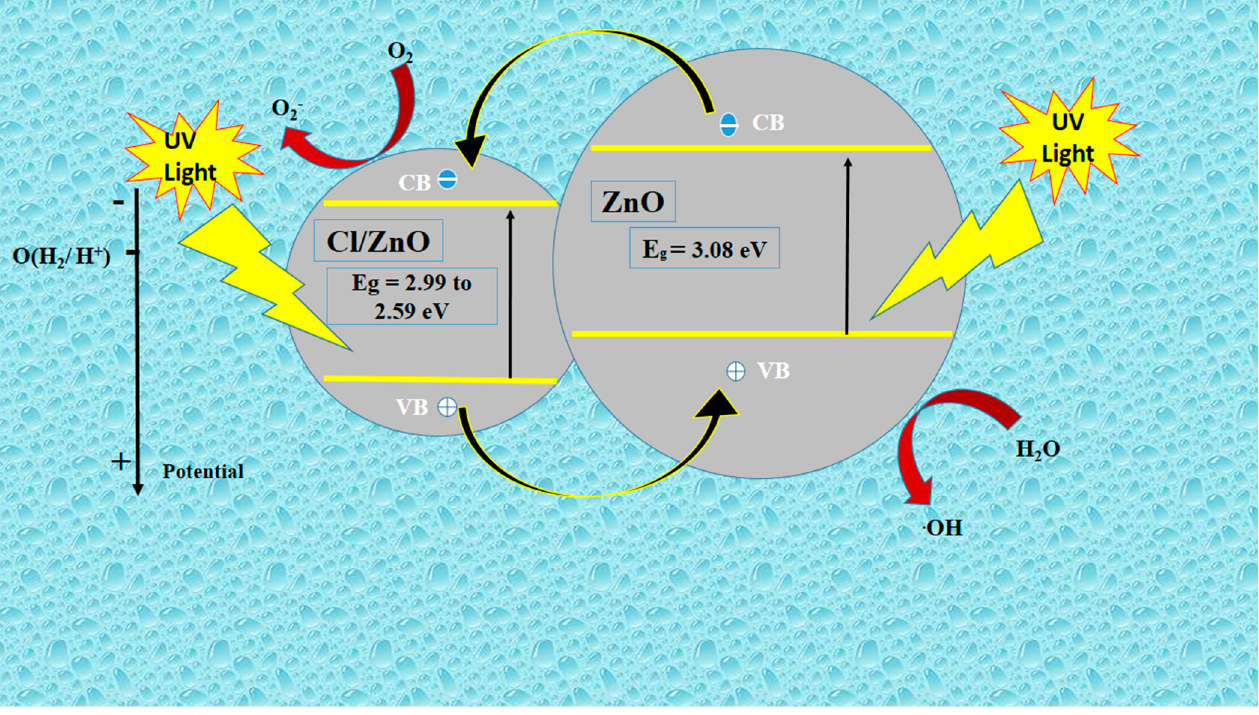
Figure 6. ( a – d ) UV–Vis absorbance spectra monitoring the concentration of MB after 15 intervals of time for 5%, 10%, 15% and 20% Cl — -doped ZnO at pH 5, respectively.